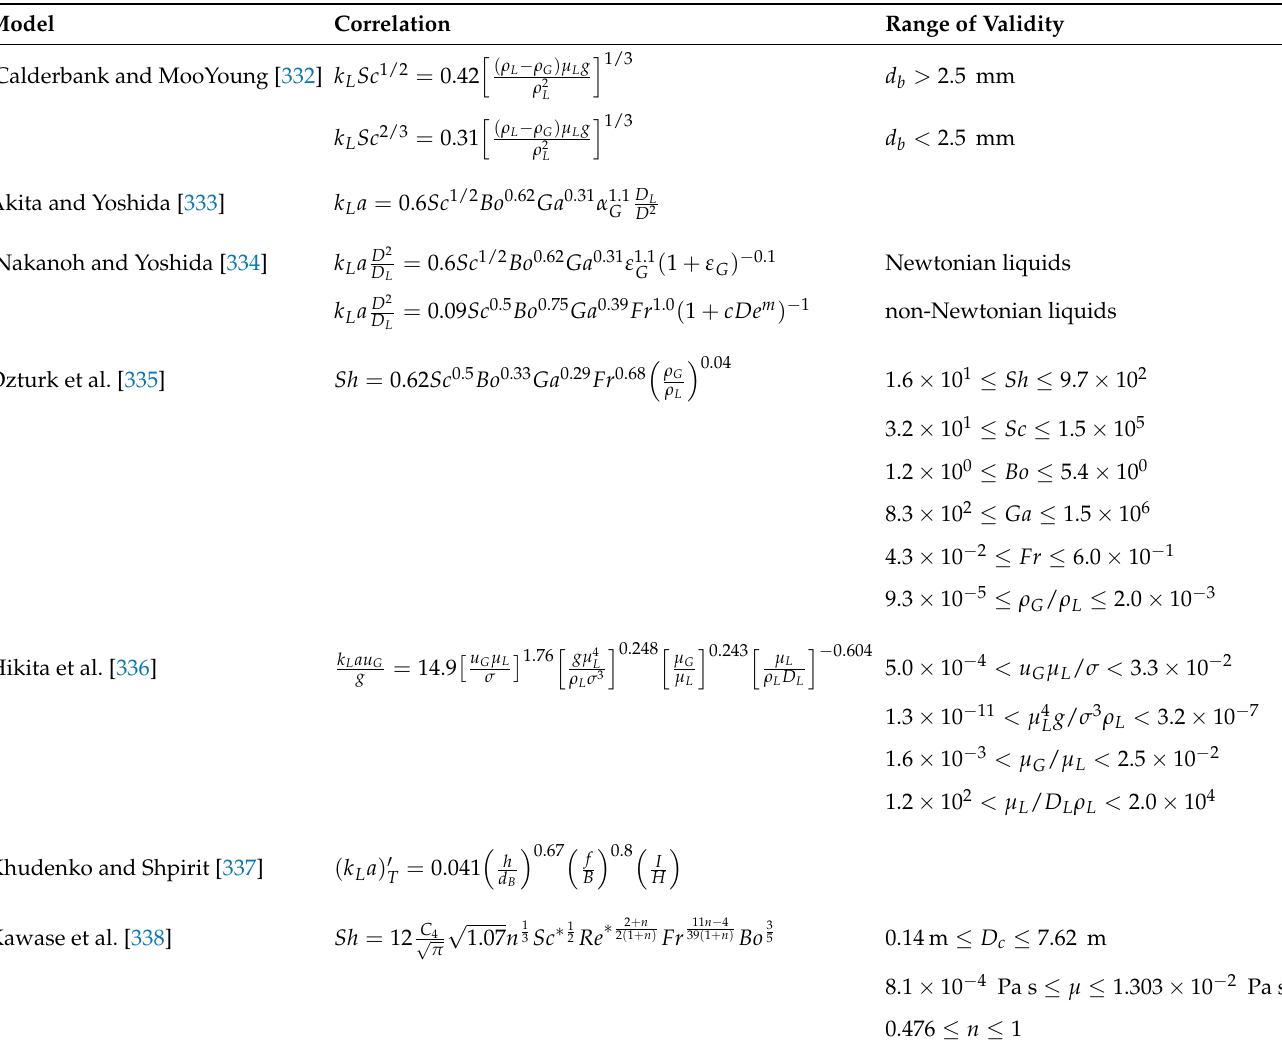
Table 13. Interphase mass transfer